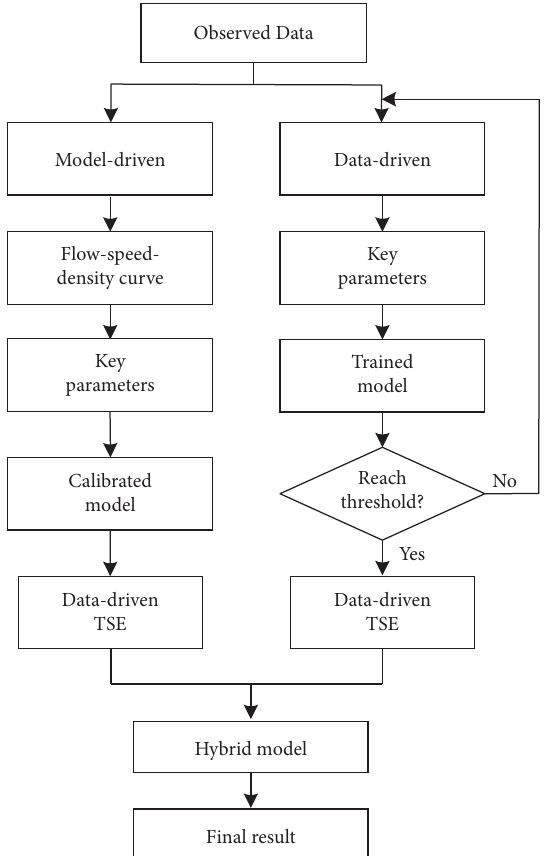
Figure 4: Te framework of the proposed TFMDL